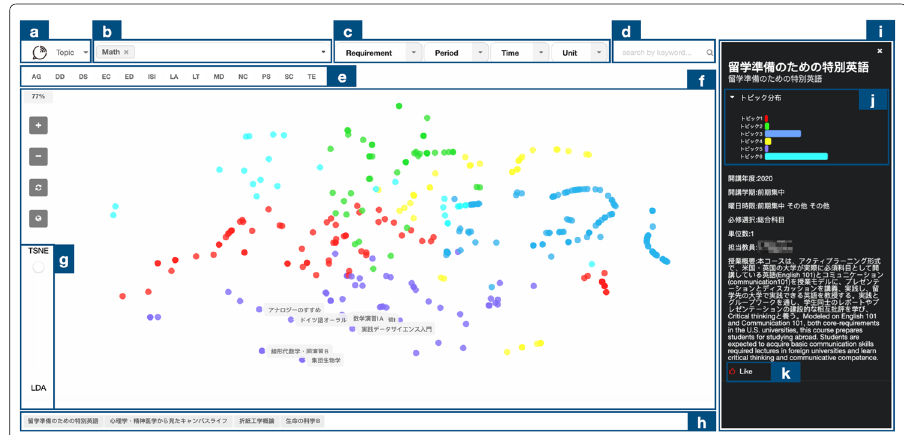
Fig. 2 The screenshot of the CourseQ interface. The interface supports the exploration of recommended courses in left and details in right. Left: (a) Navigation tab, (b) Keyword input area, (c) Filters, (d) Search bar, (e) Department information, (f) Scatter plot, (g) Visual shift slider, (h) “Like” list. Right: Detail of the course. (i) Information sidebar, (j) Topic histogram, (k) “Like” button. (Some text is in Japanese, and the instructor name has been pixelated for privacy